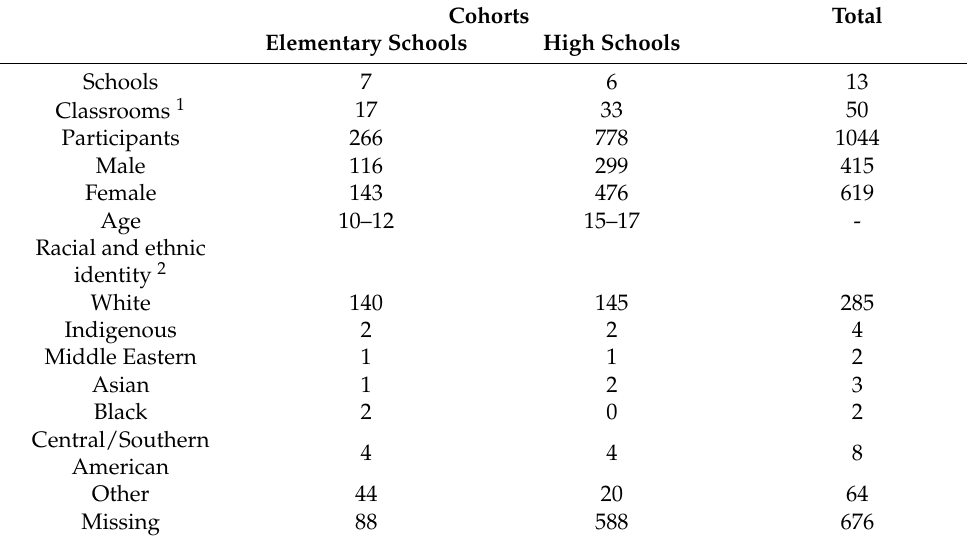
Table 1. Descriptive characteristics of the final sample. Cohorts